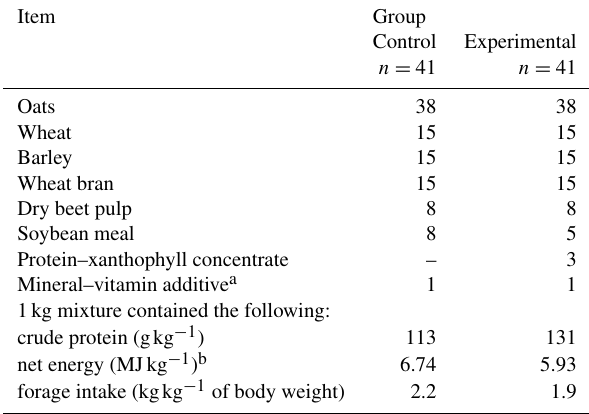
Table 1. Ingredient composition (by percent of dry weight), nutri- tional value of the analyzed diets and forage intake in the groups of